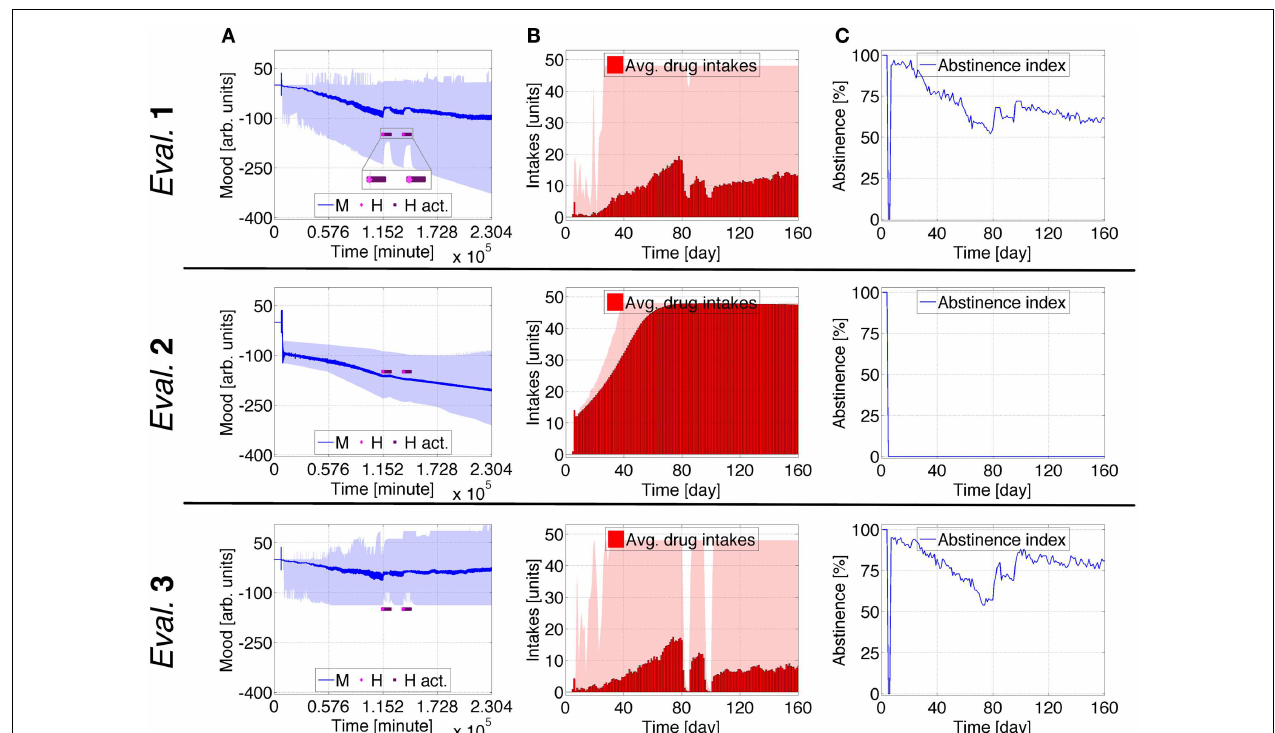
recovery process H is activated at t = 1920 and t = 2280 [hours] (in light pink) and stays active for 120h (dark pink). (A) shows the evolution of the subject’s mood M ; (B) the average number of drug intakes; and (C) the abstinence index.The shades correspond to 95% simulation envelopes.The time-scales are minutes for (A) , and days for (B,C) . Further details of these simulations are reported in FiguresS7 and S8 in Supplementary